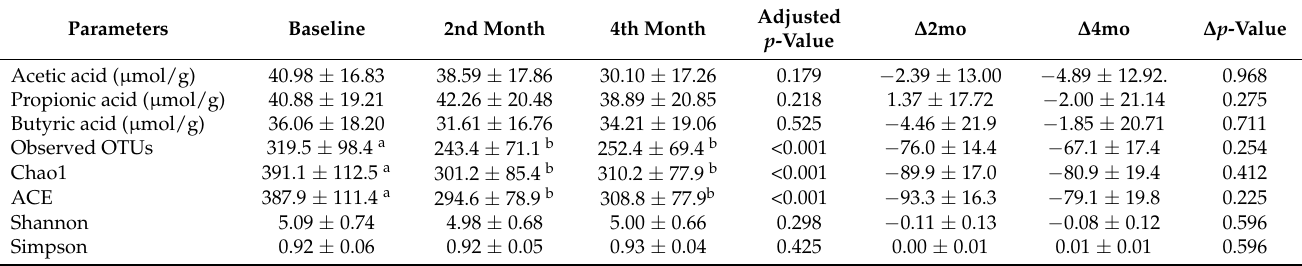
Table 5. Short-chain fatty acids and microbiome species richness and diversity in the feces.